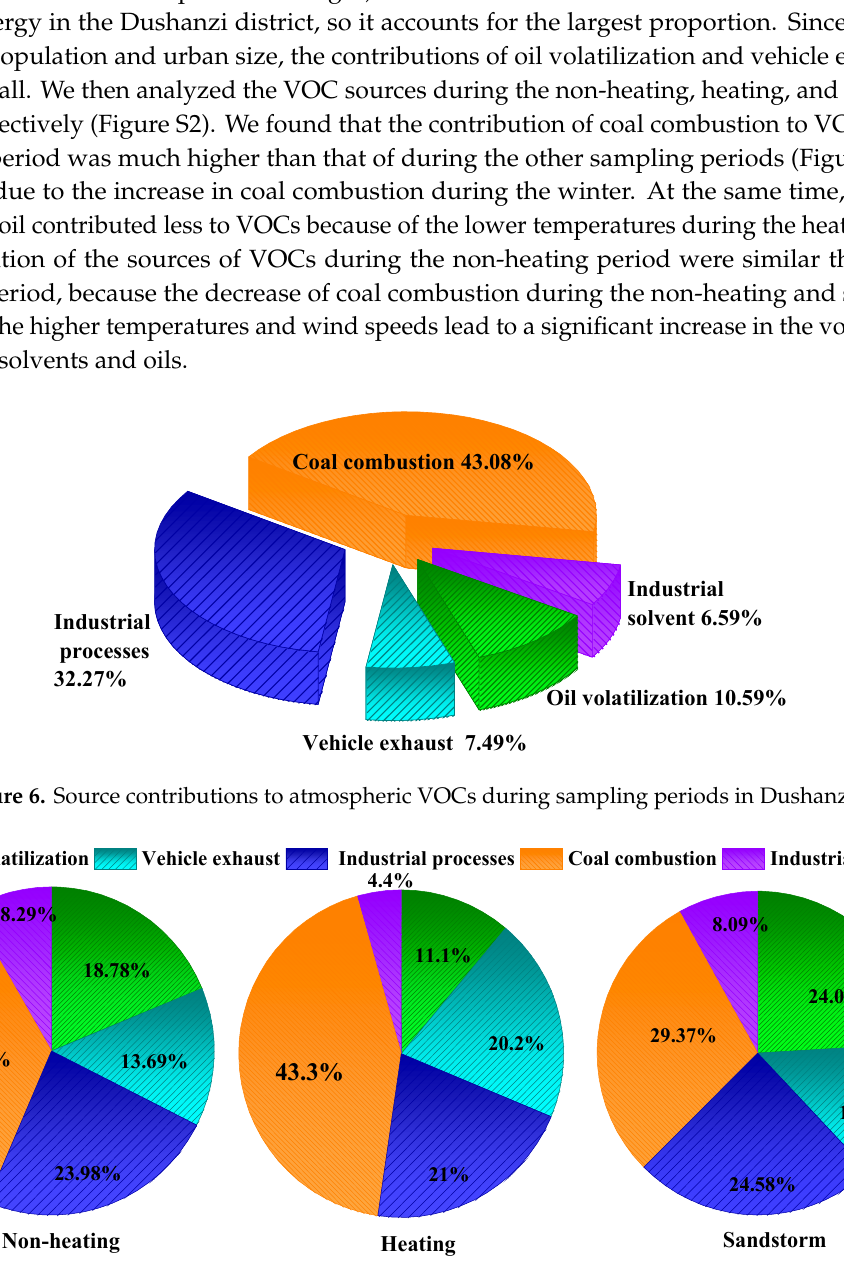
Figure 7. Contributions of the five sources to VOCs in Dushanzi during three sampling periods. Supplementary Materials: Figure S1: Relationship between ethane or acetylene and SO2 for sampling period; Figure S2: apportionment of VOCs in the non-heating (a), heating (b) and sandstorm (c) sampling periods.